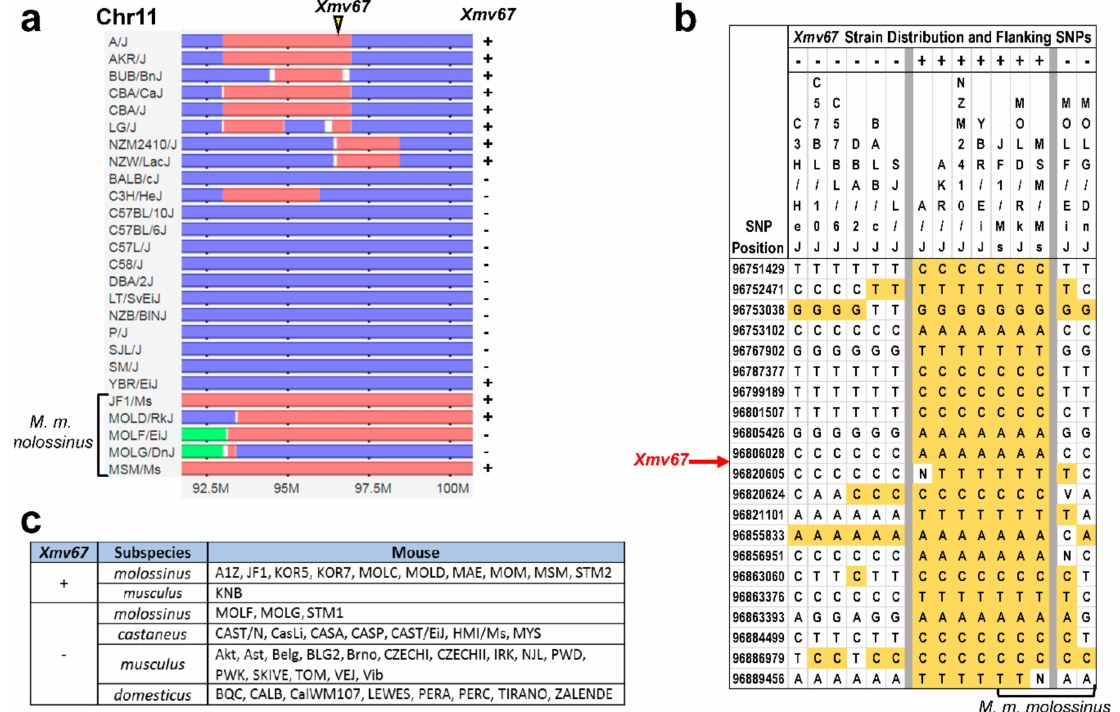
Figure 4. ERVs related to the AKR6 substitutions map to chromosomal regions that originated in Asian mice. ( a ) Horizontal tracks represent a 10-Mb segment of chromosome 11 in selected strains and subspecies typed for Xmv67 . Chromosomal regions originating from M. m. domesticus are in blue and M. m. musculus in red. PCR typing is shown on the right. The position of the AKR ERV insertion site at Chr11:97 (based on NCBI37/mm9) is marked by an inverted triangle. ( b ) Polymorphic SNPs surrounding the Xmv67 insertion site are shown for a subset of the tested mice. Yellow highlights the AKR-specific SNPs. ( c ) Distribution of Xmv67 in subspecies of M. musculus